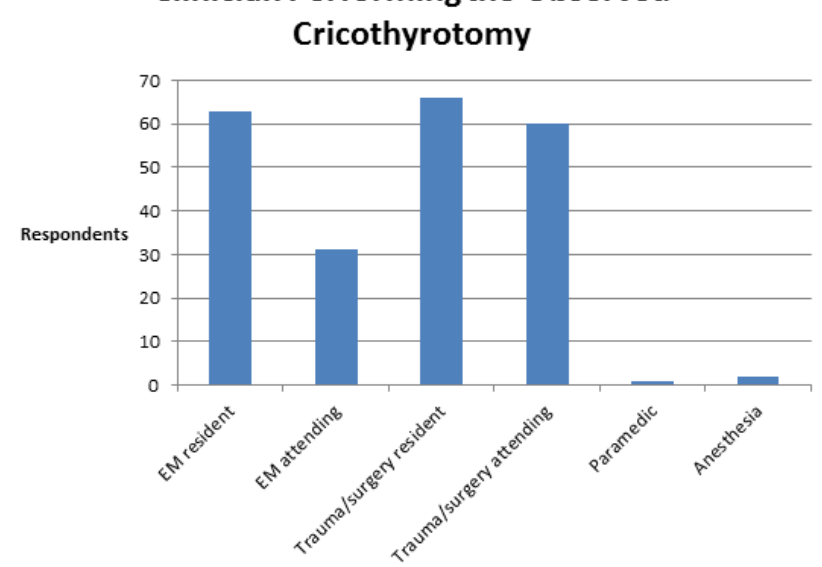
Figure 2 . Background of clinicians who performed cricothyrotomies that residents observed but did not perform